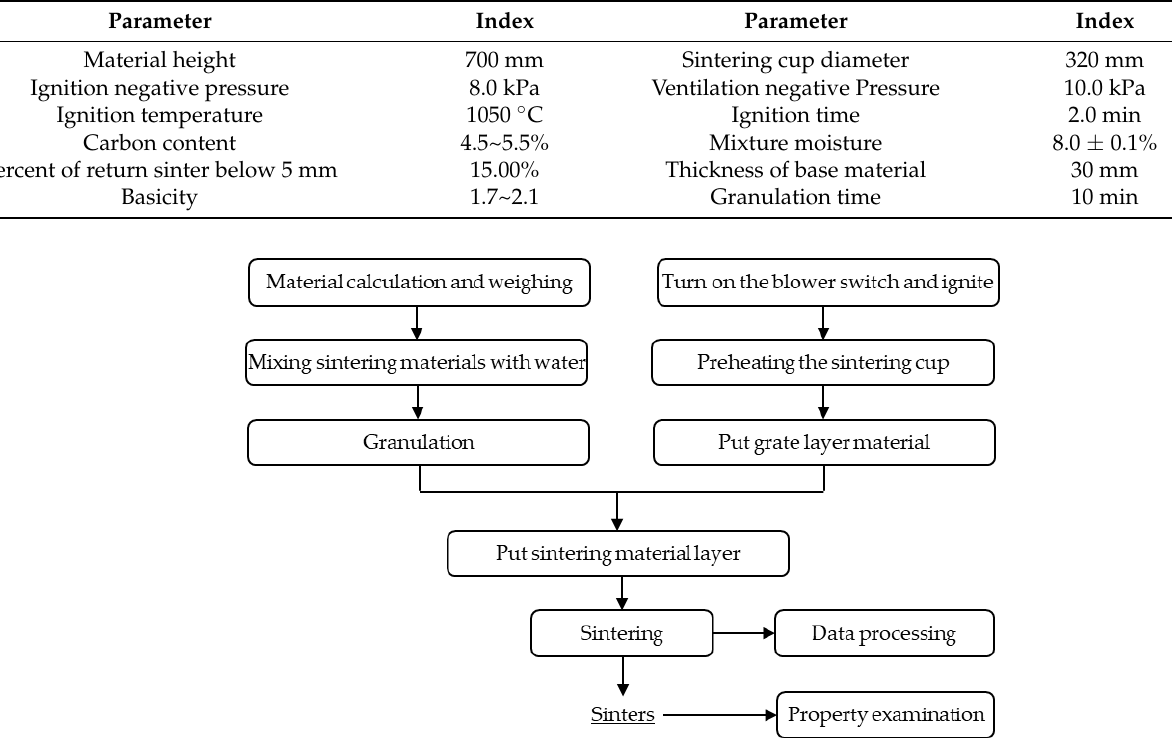
Figure 2. Flow chart of laboratory sinter production.